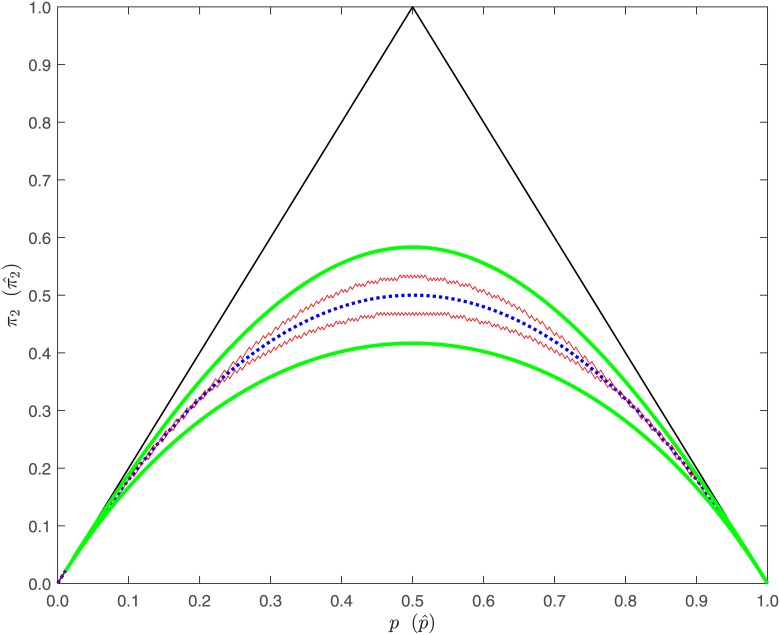
De Finetti diagram of the boundary curves of the equivalence region specified under the alternative hypotheses of (1).Ragged lines: critical region of the test to be generalized for X-chromosomal SNPs. [δ° = 0.96, α = 0.05, n = 200].